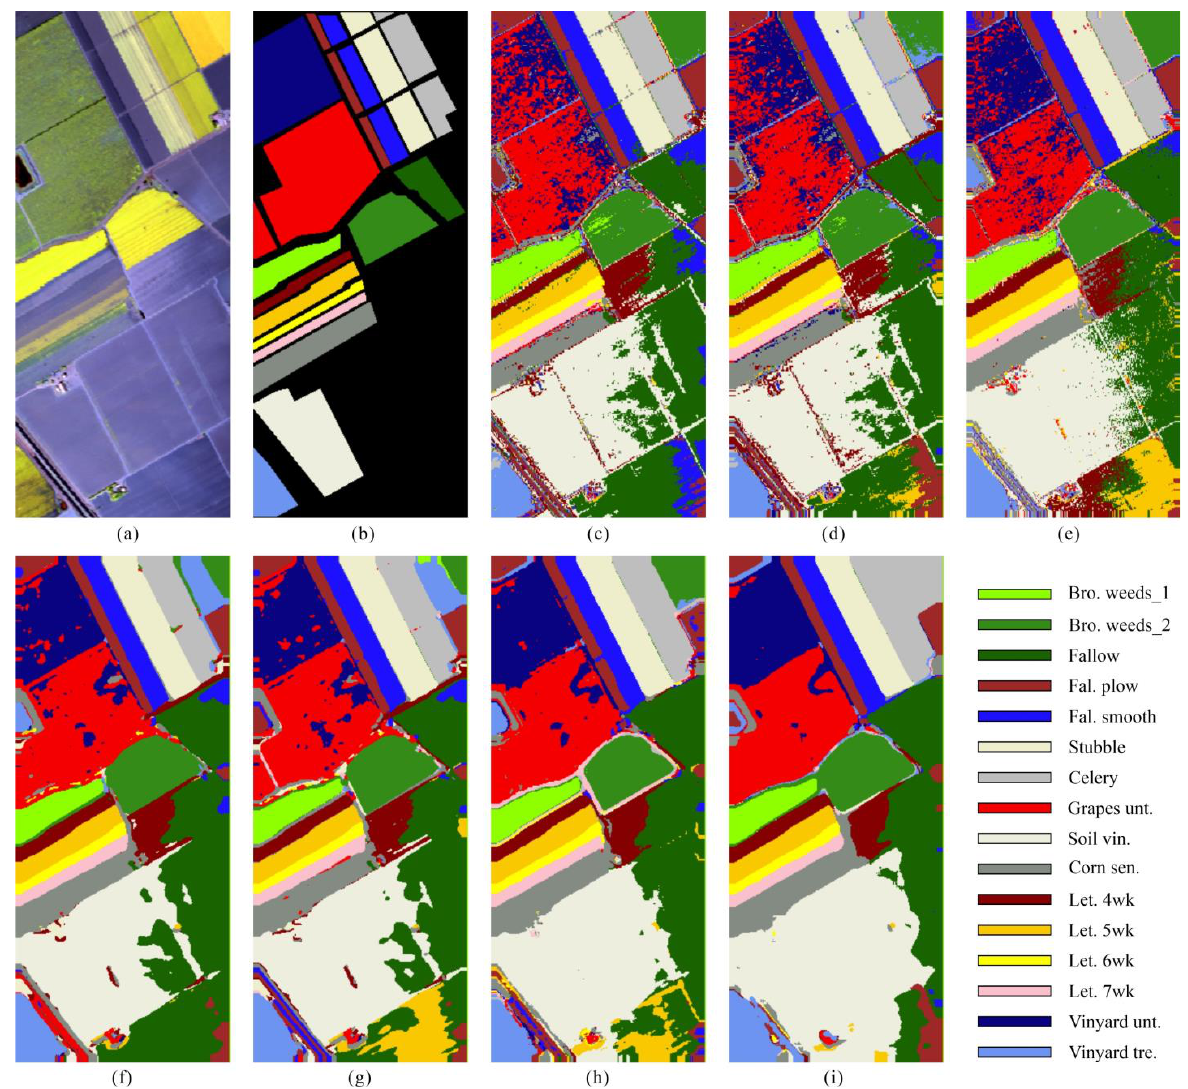
Figure 10. The classification results obtained using different methods on the Salinas Valley dataset. ( a ) Three-band composite image of the Salinas Valley HSI. ( b ) The ground truth of Salinas Valley HSI. The classification results of ( c ) SVM, ( d ) 1D CNN, ( e ) R2D, ( f ) 2D CNN, ( g ) 3D CNN, ( h ) MCM, and ( i ) LGSF.